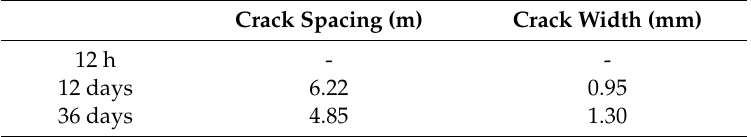
Table 2. Mean values of the transverse crack spacing and width at di ff erent times.